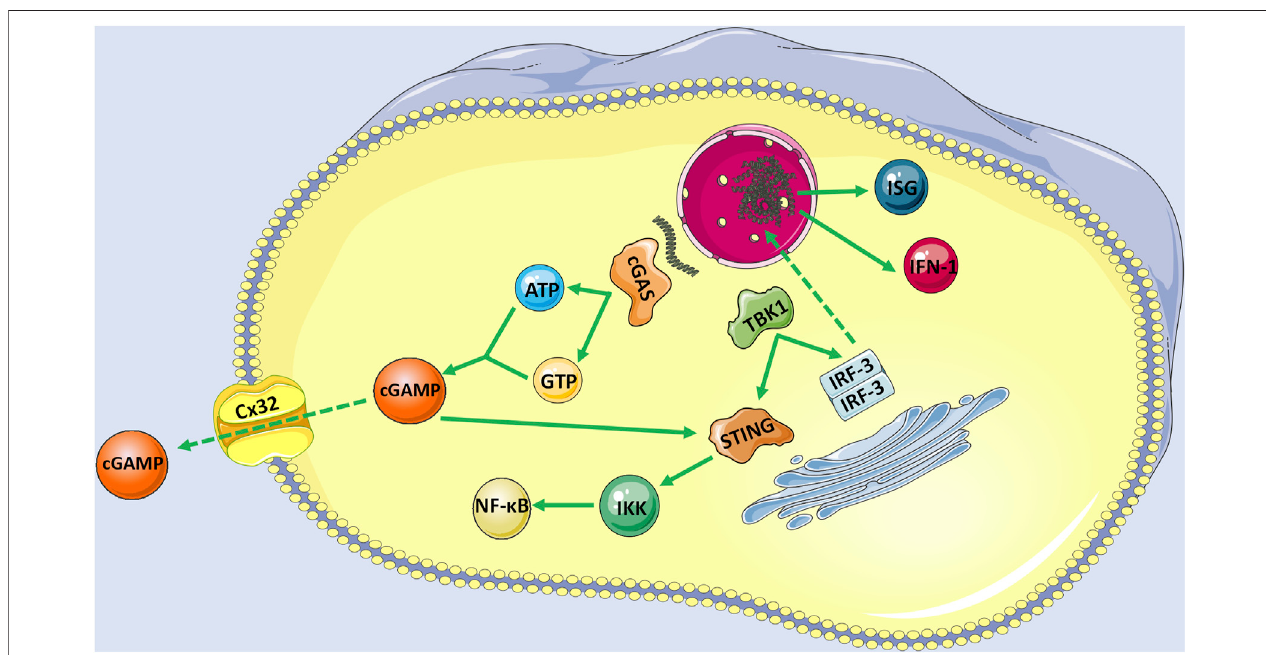
FIGURE 1| The activation of cGAS-STING signaling pathway with endogenousDNA asan example. When cGAS bind to DNA, ATP and GTP act as substrates to activate cGAS to catalyze the formation ofcGAMP, which is asecond messenger to activate STING. cGAMP also transactivates STING in adjacent cells withthe help of gap junction proteins such as Cx32. Activated STING is fi rstly palmitoylated in the Golgi apparatus and then recruits the TBK1. Conversely, the C-terminal domain of STING is phosphorylated by TBK1, and phosphorylated STING recruits RF3, which is also phosphorylated and dimerizes by TBK1. Finally, dimerized IRF3 enters the nucleus and plays its role in the transcription of IFN-1 and ISGs. Moreover, STING can also bind to IKK and activate its mediated NF- κ B.